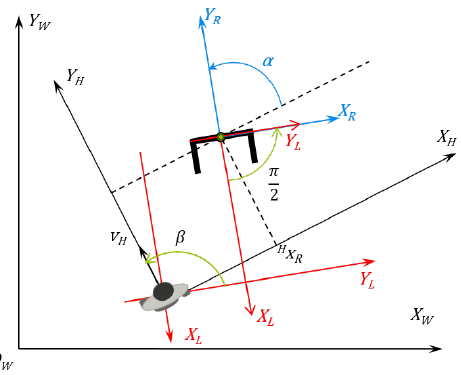
Figure 15. Conversion from the laser reference to the robot reference. Note that the β angle goes from the X H axis up to the Y L axis. Since it goes clockwise, it is